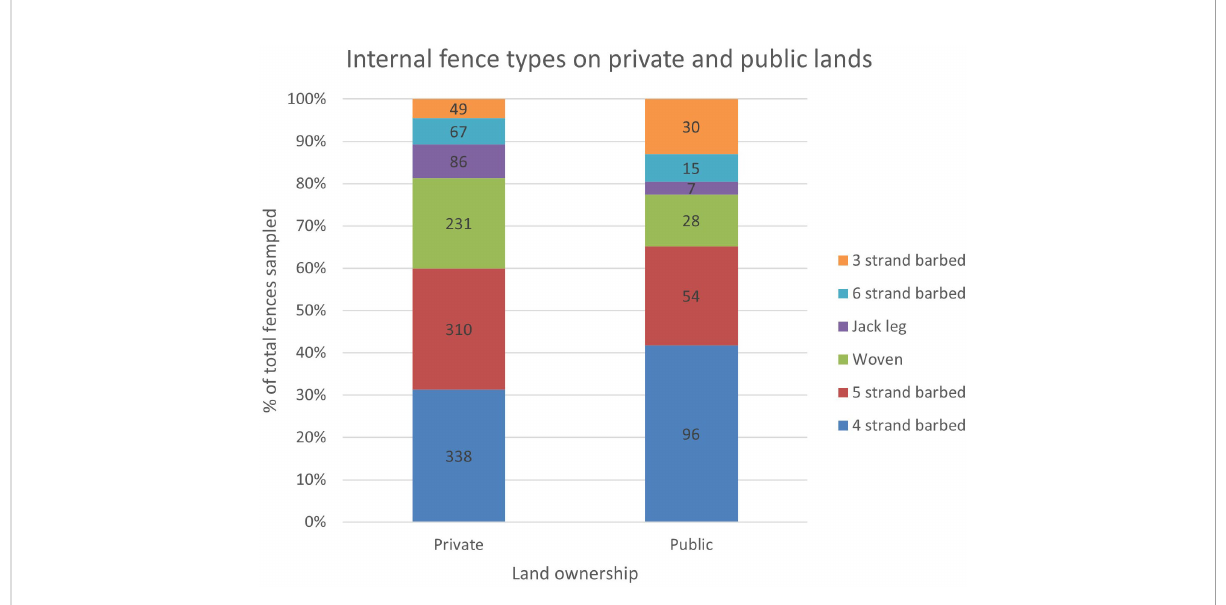
FIGURE 4 Proportions and counts of the six most common internal (i.e., pasture) fence types sampled on private lands (n = 1,130) and public lands (n = 242) in Beaverhead and Madison Counties, MT. Fence type and land ownership type were correlated ( c 2 = 45.52, df = 5, p =